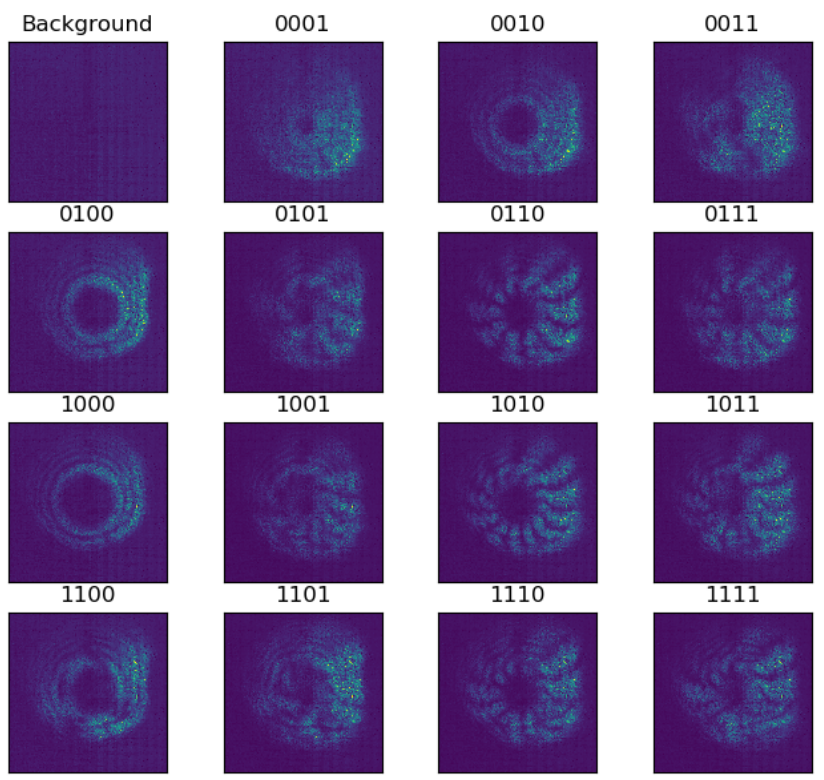
Figure 5. Example of OAM patterns from the underwater data set.